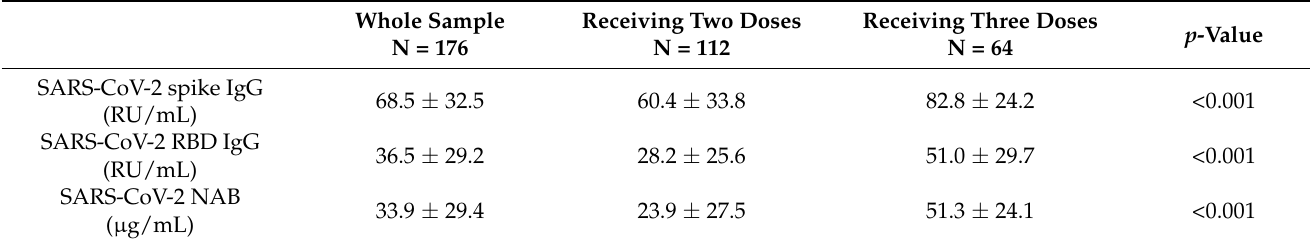
Table 3. The level of anti-SARS-CoV-2 antibodies regarding the number of received vaccine doses. Whole Sample N = 176 N = 112